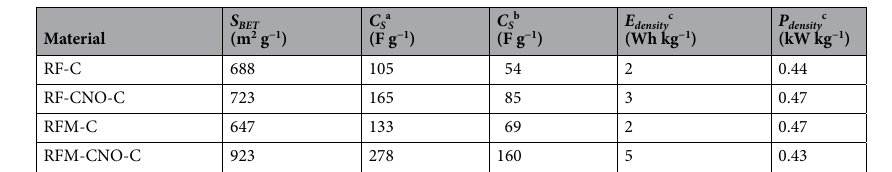
Table 3. Specific capacitance, energy and power density values calculated from the GCD studies. a Specific capacitance calculated from CV curves at the sweep rate of 50 mV s −1 (three-electrode configuration). Calculated based on Eq. (1). b Specific capacitance calculated from GCD studies at the current density of 2 A g −1 and potential window from 0 to + 700 mV (two-electrode configuration). Calculated based on Eq. (2). c E density and P density calculated from GCD studies at the current density of 2 A g